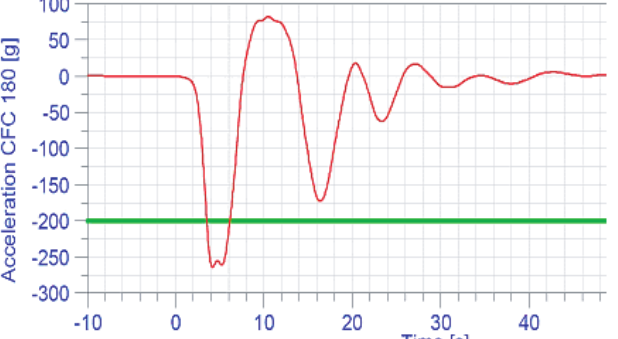
Fig. 3. Acceleration plot of legform impact test.